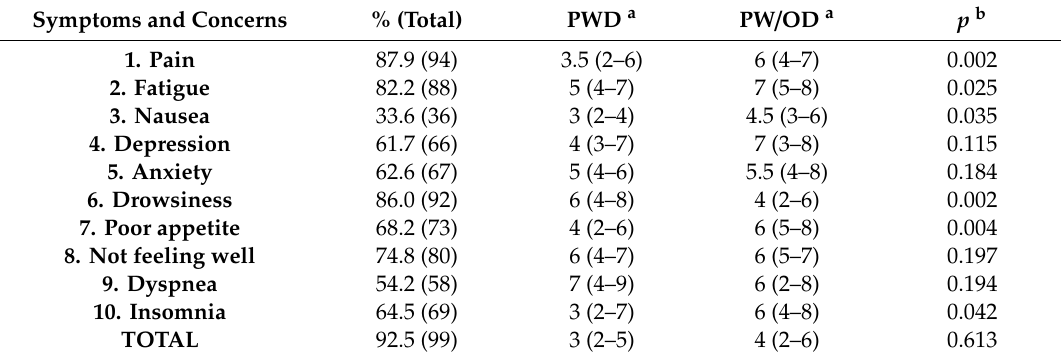
Table 2. Comparison of intensity of perceived symptoms using the Edmonton Symptom Assessment System (ESAS) in patients of Nursing Homes with or without